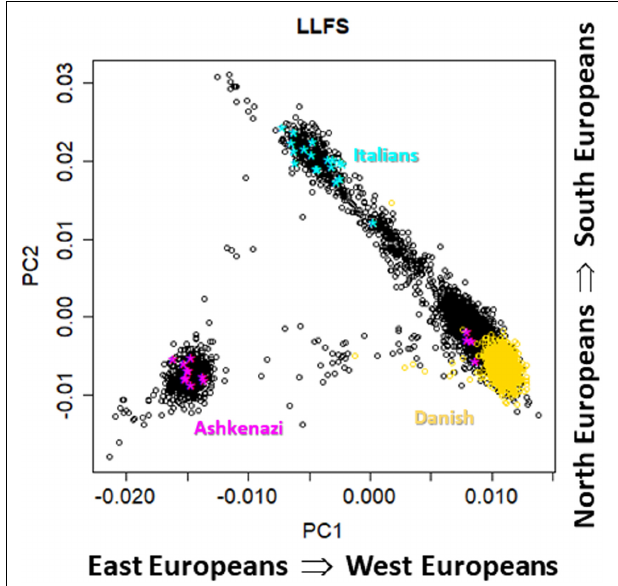
FIGURE 2 | Scatter plot of the first two principal components from genome-wide principal components analysis in 4,630 LLFS participants. Gold: participants enrolled at the Danish field center; cyan: participants born in Italy; magenta: participants born in Poland or Russia.